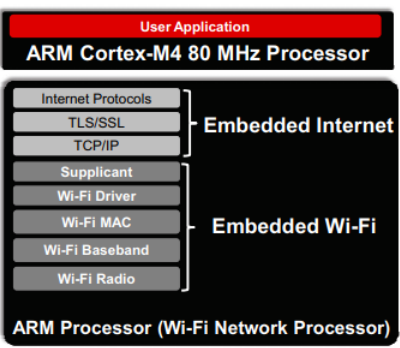
Figure 3. CC3200 Embedded Software Overview